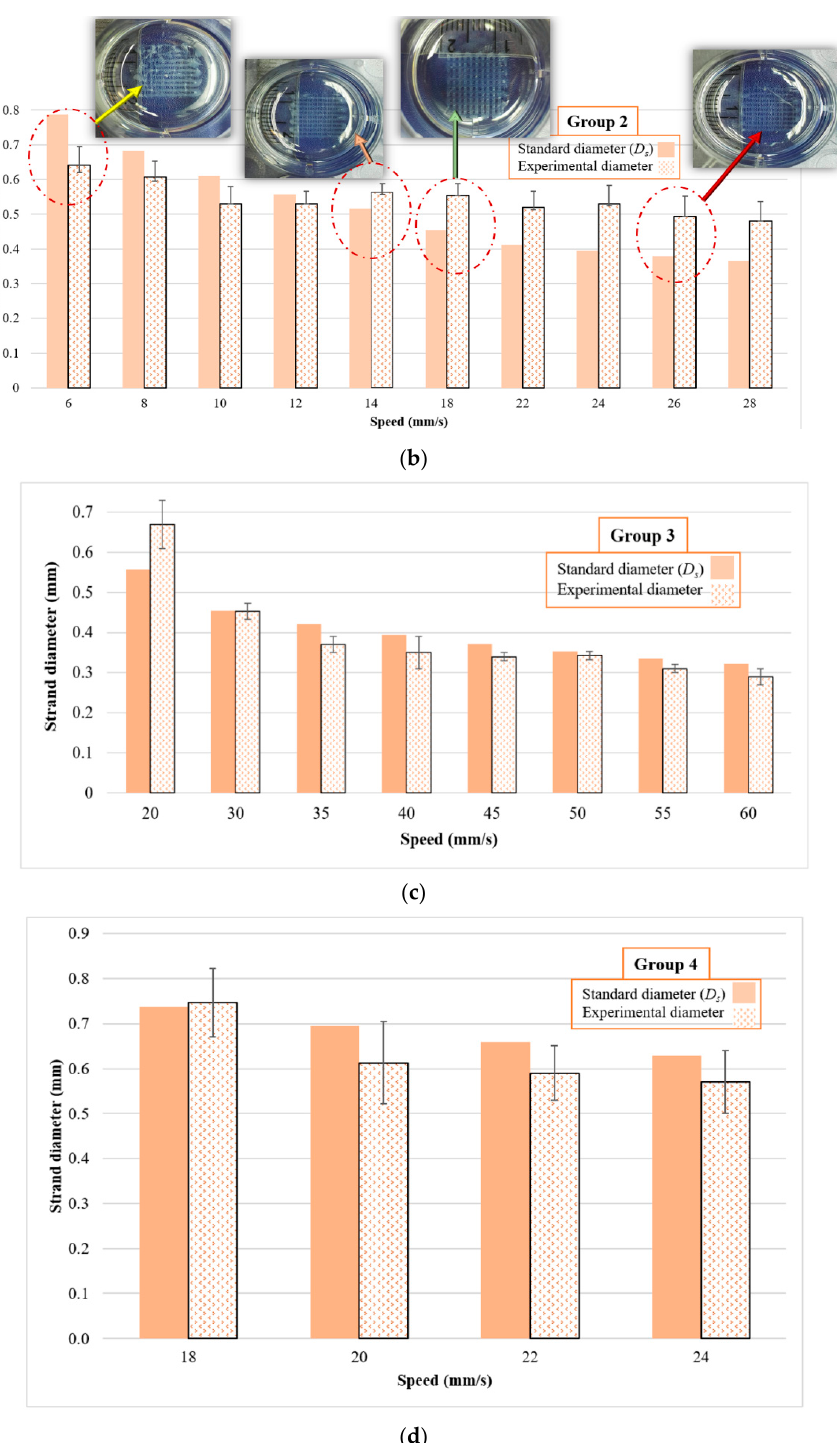
Figure 6. Effect of nozzle speed on the printability of Groups 1 to 3 (pressure: 0.2 bar) and 4 (pressure: 0.1 bar): comparison between Ds and experimental strand diameter (inset images are printed scaffolds for Group 2 at different nozzle speeds of 6, 14, 18, and 26 mm/s, as an illustration). ( a ) group 1; ( b ) group 2; ( c ) group 3; and ( d ) group 4. Strand printability and pore printability results are shown in Table 2. Values that were close to 1 ± 0.1 were considered acceptable for both pore and strand